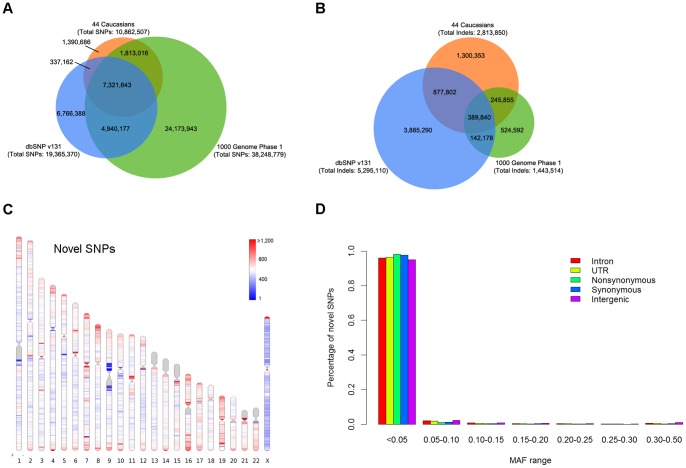
Summary characterizations of the identified variants.
A–B, Venn diagram showing SNPs and indels identified in the present study overlapping with those archived in the dbSNP (v131) and the 1000 Genomes Project Phase 1 data sets (released on 5/21/2011). To account for differences in placement of many indels between different data sets, indels were considered to match if they were within 25 bp distance and of the same size. Only SNPs and indels mapped to autosomes and X chromosome were analyzed. C, Genome-wide distribution of novel SNPs. Total number of novel SNPs (compared to dbSNP v131 and the 1000 Genomes Project pilot phase) were calculated in non-overlap 1-megabases (Mb) windows across the human genome and plotted in ideograms using Idiographica
[41]. The diversities were illustrated by colors, with red indicating higher numbers or proportions and blue indicating lower numbers or proportions. Genomic regions in which no SNPs were identified or no reference sequences could be determined are shown in grey. D, Allele frequency spectrum of novel SNPs.